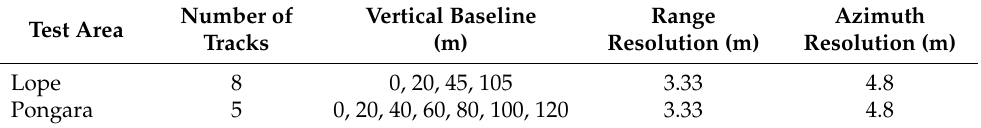
Table 2. Summary of UAVSAR